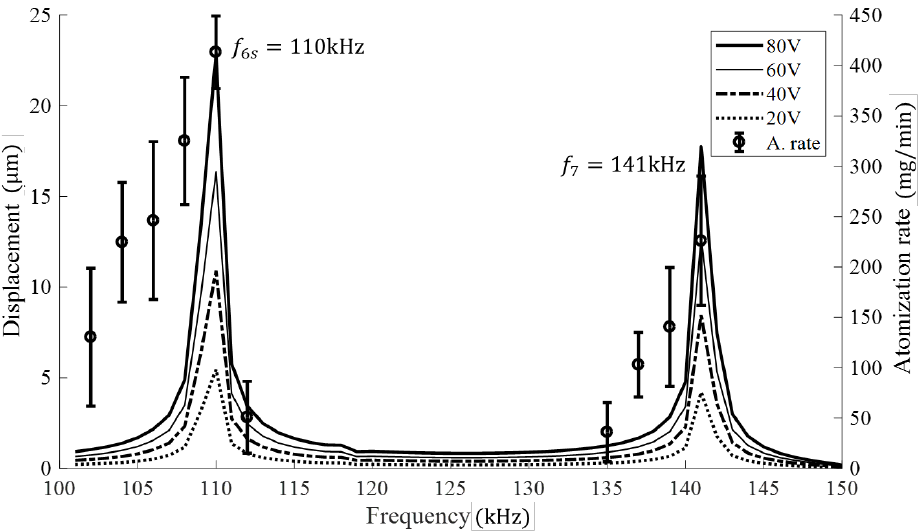
Figure 13. Comparison between the frequency sweep FEM results for different voltages and the experimental results of the atomization rate.